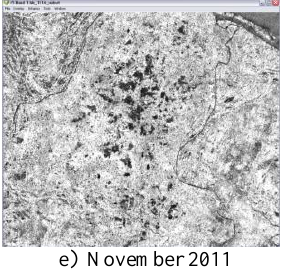
Figure 1. Processed SAR Multi-temporal Images; HH Polarization